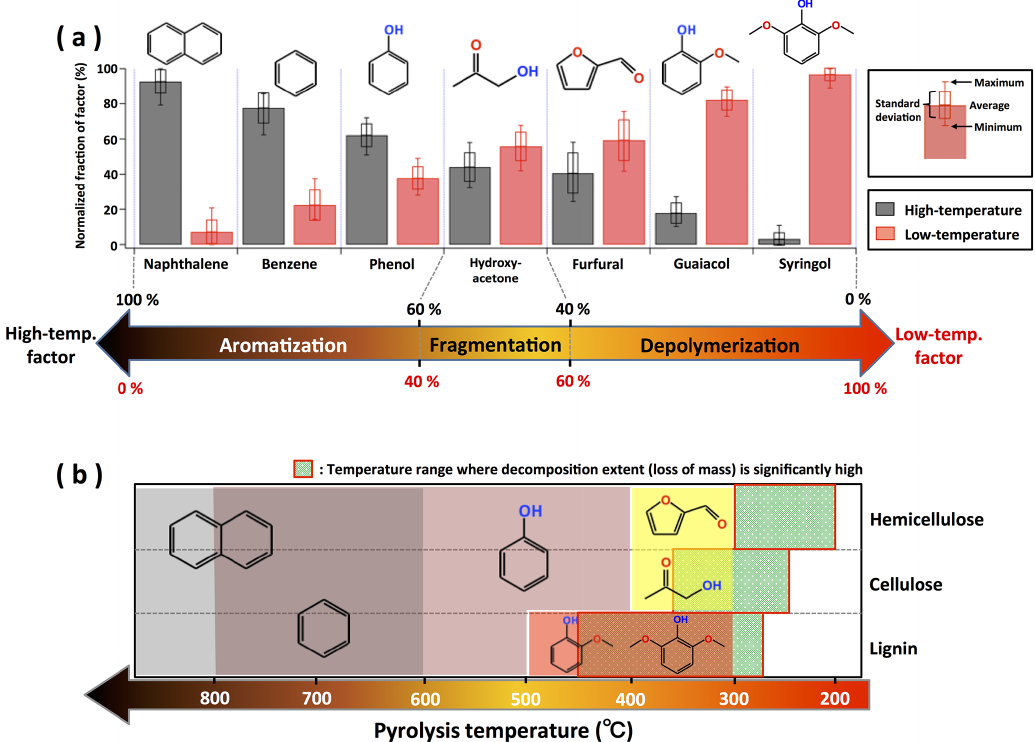
Figure 4. (a) Normalized fraction of factors for selected biomass pyrolysis products, obtained using PMF results of 15 different fuels. (b) Di- agram of the relationship between pyrolysis temperature and products for hemicellulose, cellulose, and lignin, as reported in the literature (Collard and Blin, 2014). Individual color bars show the temperature range to form specific products described by chemical